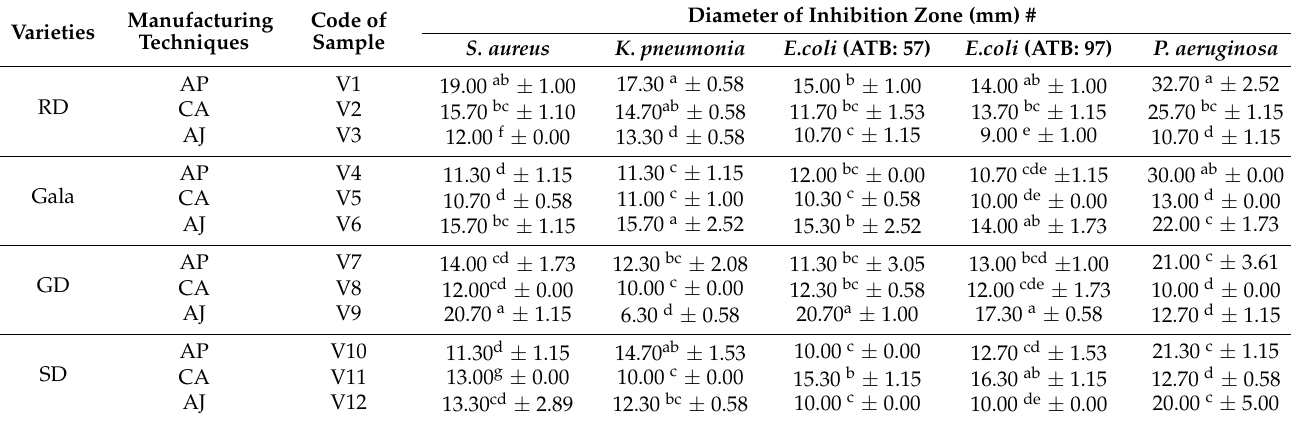
Table 2. Diameters of inhibition zones (mm) of apple vinegar relative to the bacteria tested.